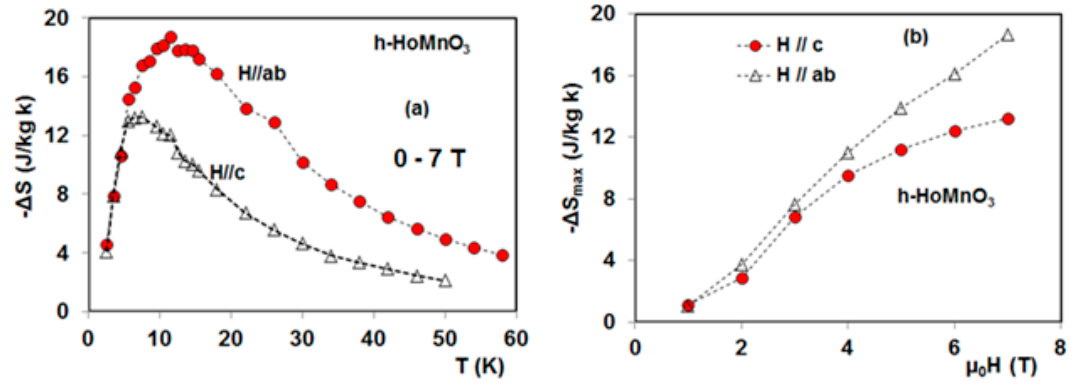
Figure 9. ( a ) Isothermal entropy change as a function temperature of the hexagonal HoMnO 3 for a magnetic field variation from 0 to 7 T along the easy and hard-directions. ( b ) Its maximum value as a function of magnetic field [27].